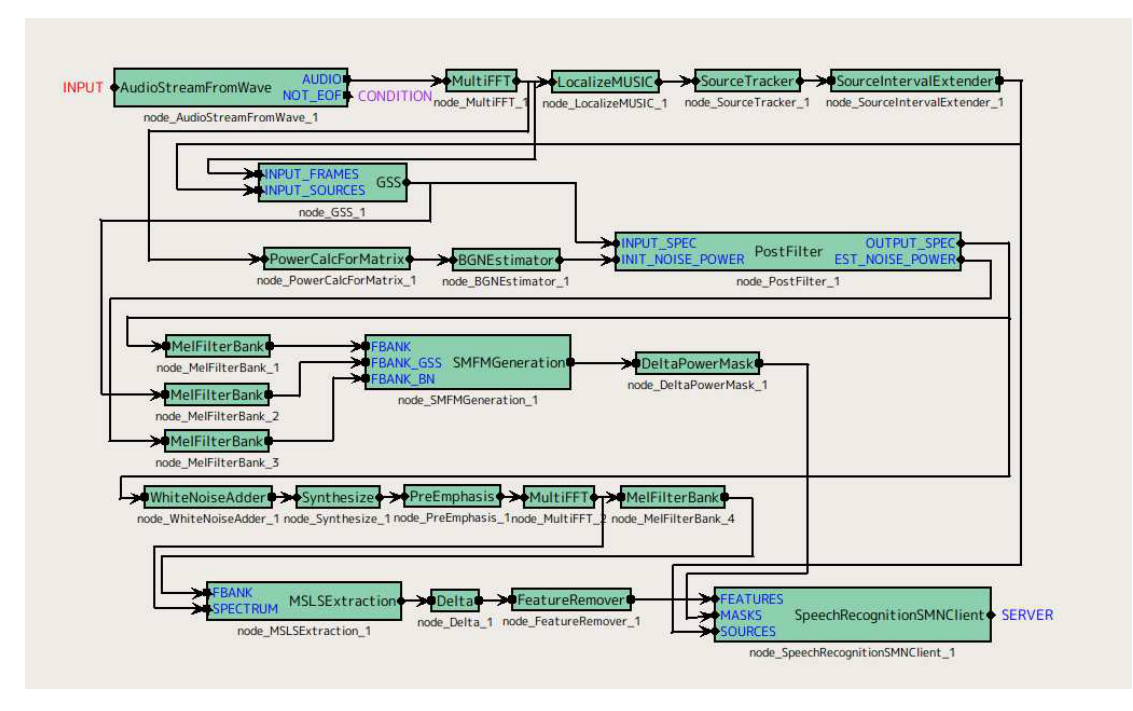
Figure 4. A robot audition system constructed by HARK modules.